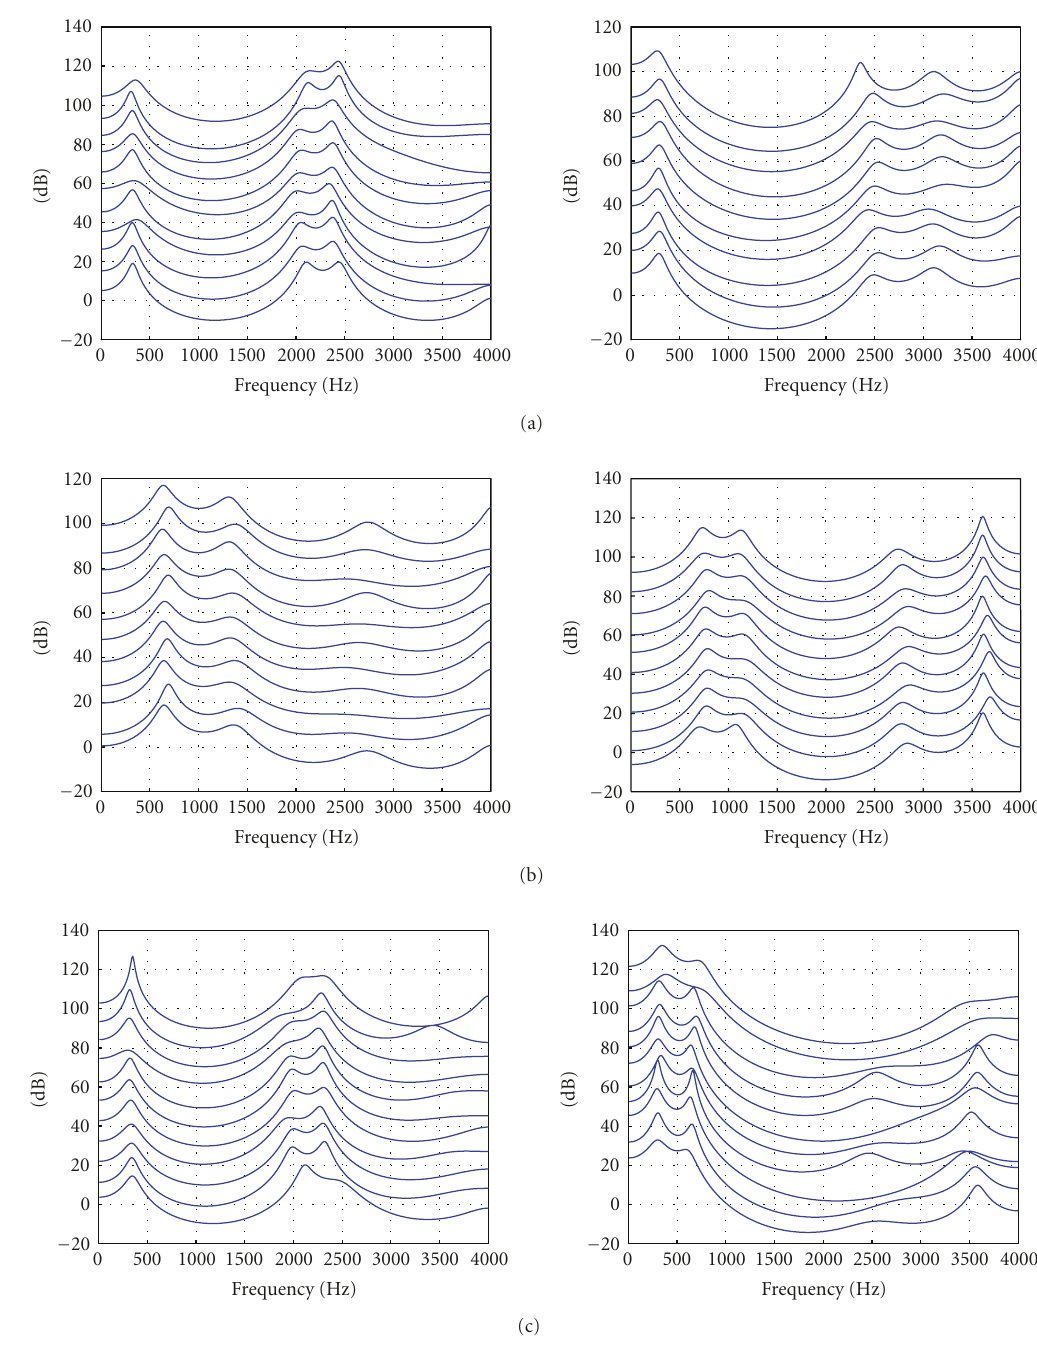
Figure 1: LP spectra of 11 successive closed-glottis regions of (a) front vowel /i/ , (b) mid vowel /a/ , and (c) back vowel /u/ from simultane- ously recorded TM speech and NM